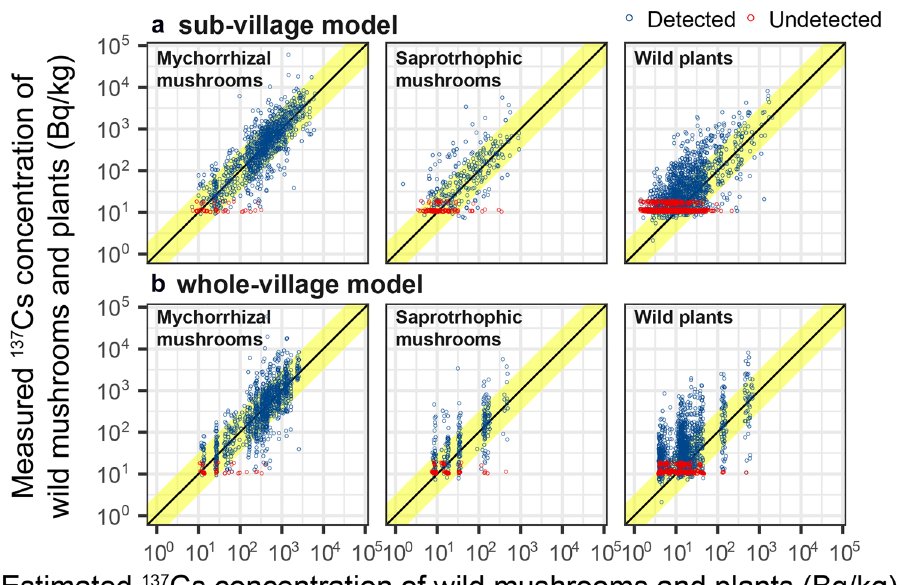
Figure 2. Comparison between measured and estimated 137 Cs activity concentration of wild mushrooms and plants. For estimated values, each sample’s posterior median using the sub-village model ( a , upper) and the whole village model ( b , lower) is shown on the horizontal axis. The results were separately plotted for mycorrhizal mushrooms (left), saprotrophic mushrooms (center), and wild plants (right). The scales of both axes are logarithmic. Red symbols indicate the measured values were less than detection limits that were plotted as measured values. The points on the yellow bands indicate that the estimated values fell within 10-folds variation from the measured values. Table S3 shows the number and percentage of detected data falling into the